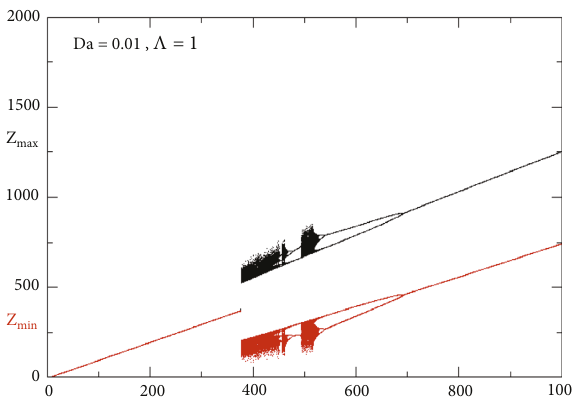
Figure 14: Diagrams of bifurcations of Z as a function of r representing the maxima and minima of the posttransient solution of Z ( τ ) for Da � 0 . 01 Λ � 1, s � 0, Ta � 0, k � π /